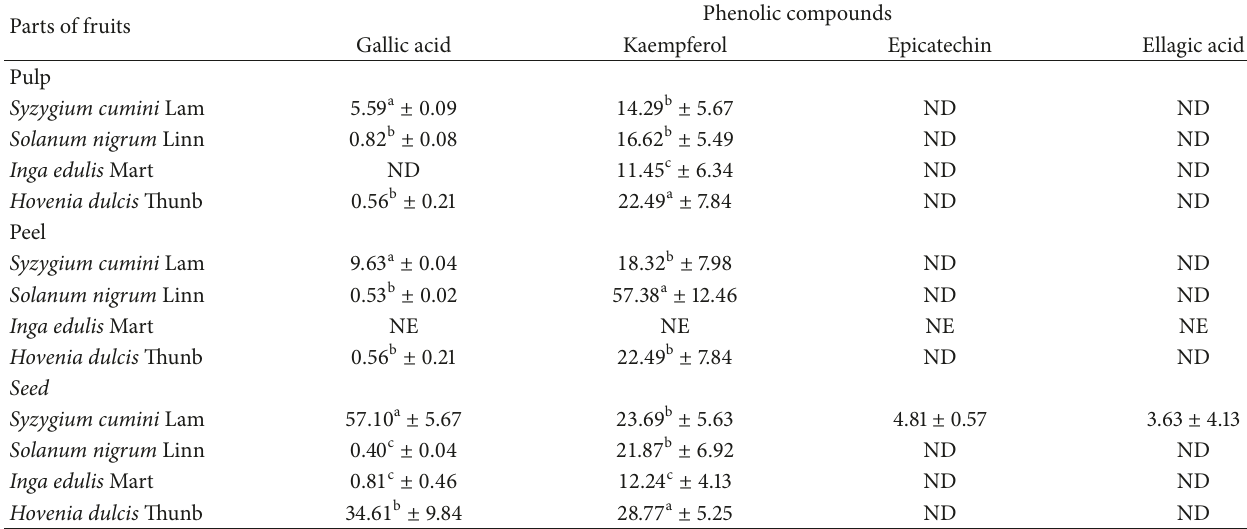
Table 3: Quantification of phenolic compounds in different parts of fruits (mg/100g